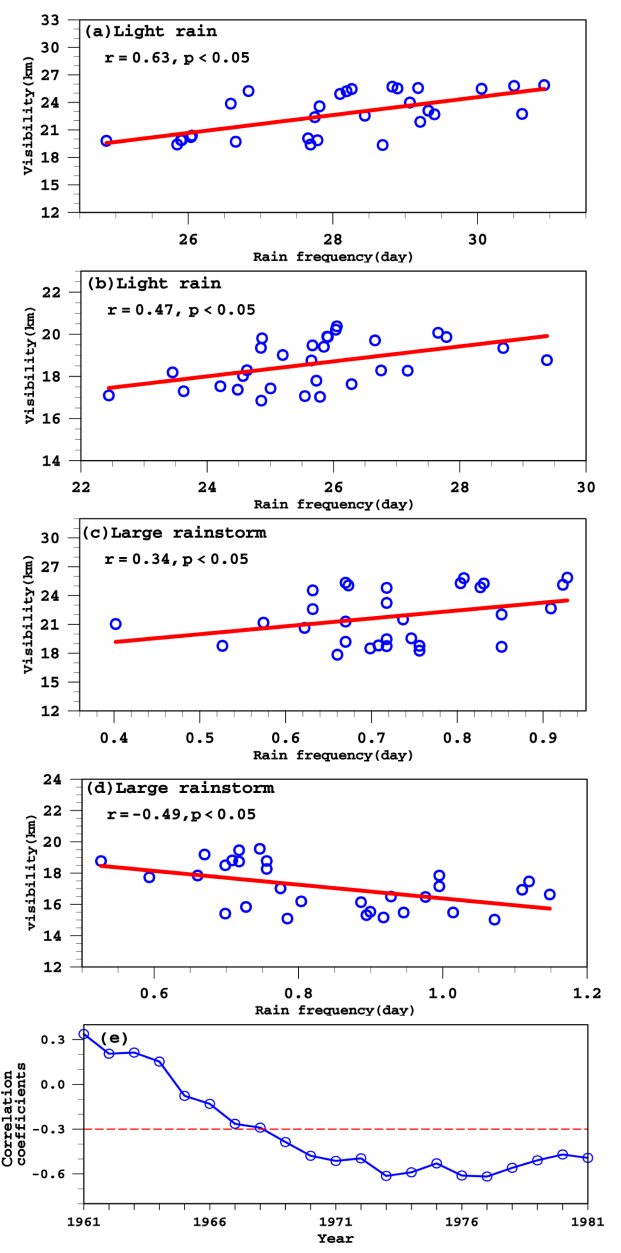
Figure 7. Correlation between summer average visibility (June– August) with light rain frequency (a) in 1961–1990, (b) light rain frequency in 1981–2010, (c) extremely heavy rain event frequency in 1961–1990 and (d) extreme heavy rain event frequency in 1981– 2010; (e) the 20-year running correlation coefficients of visibility and precipitation over EC with a dashed line standing for when the correlation passes the confidence level of 90%.